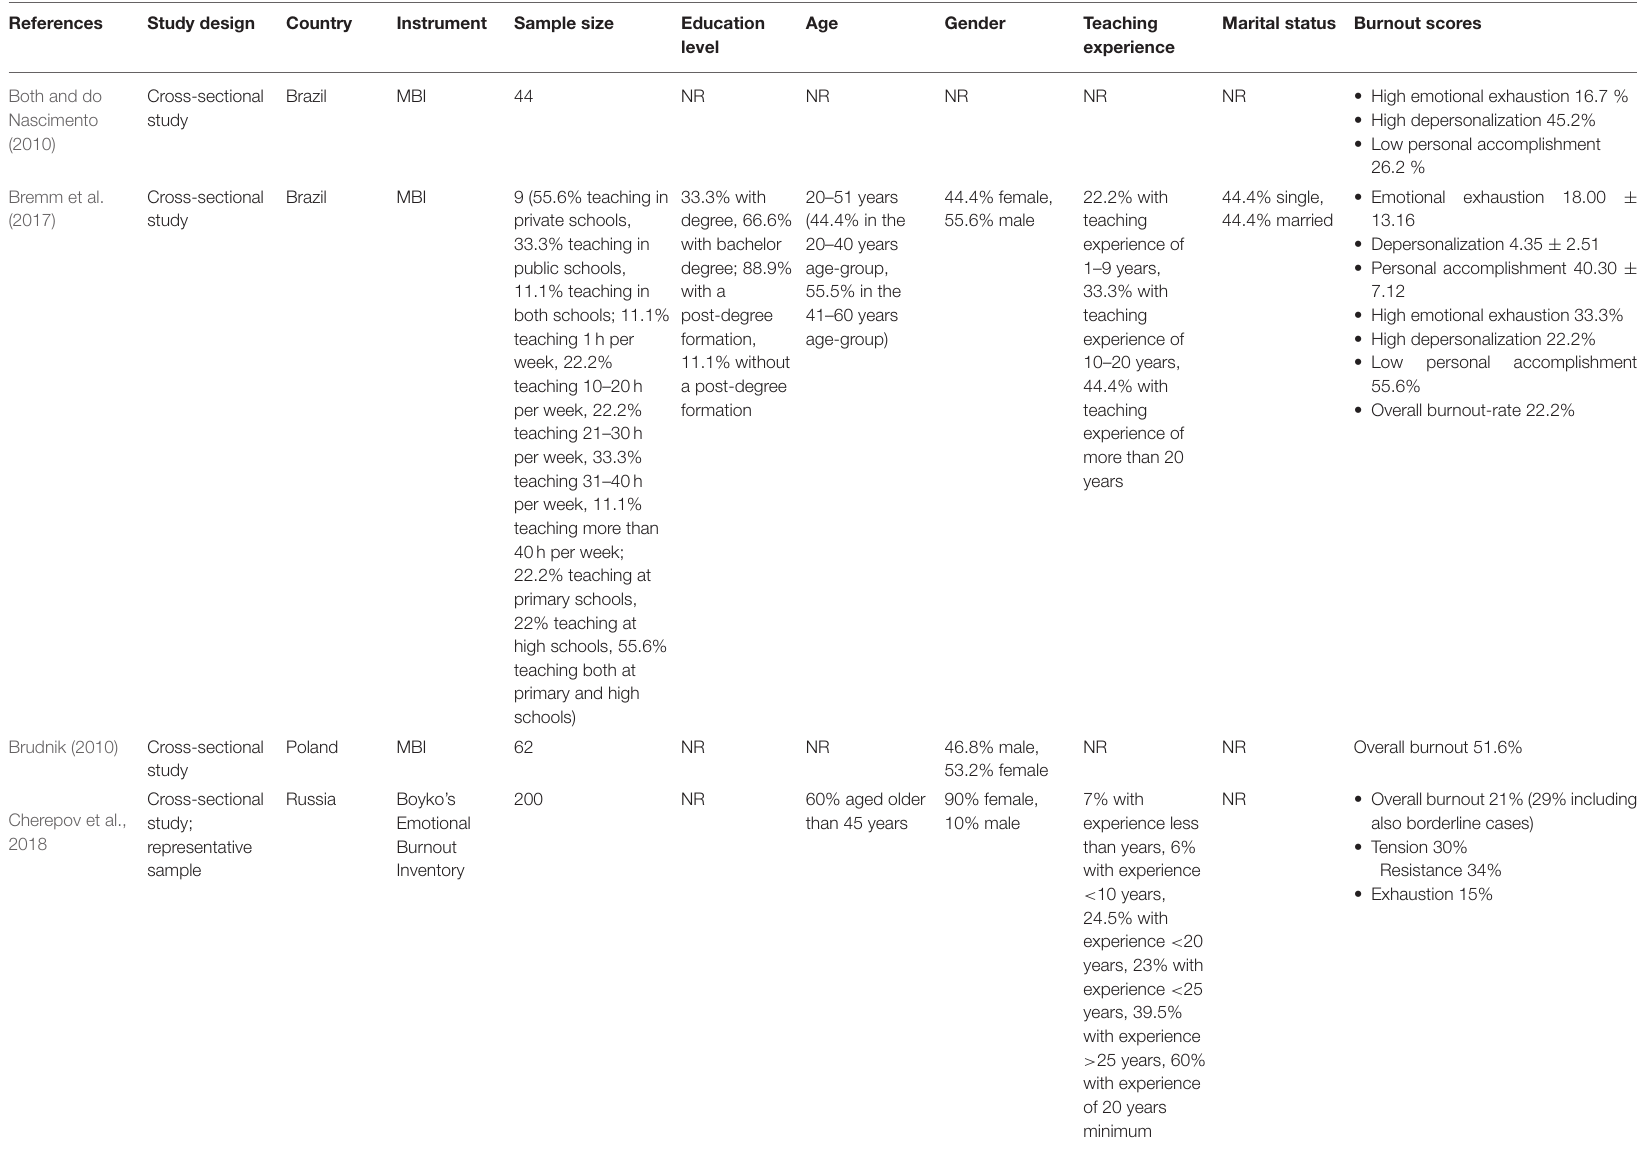
TABLE 2 | Main characteristics of included